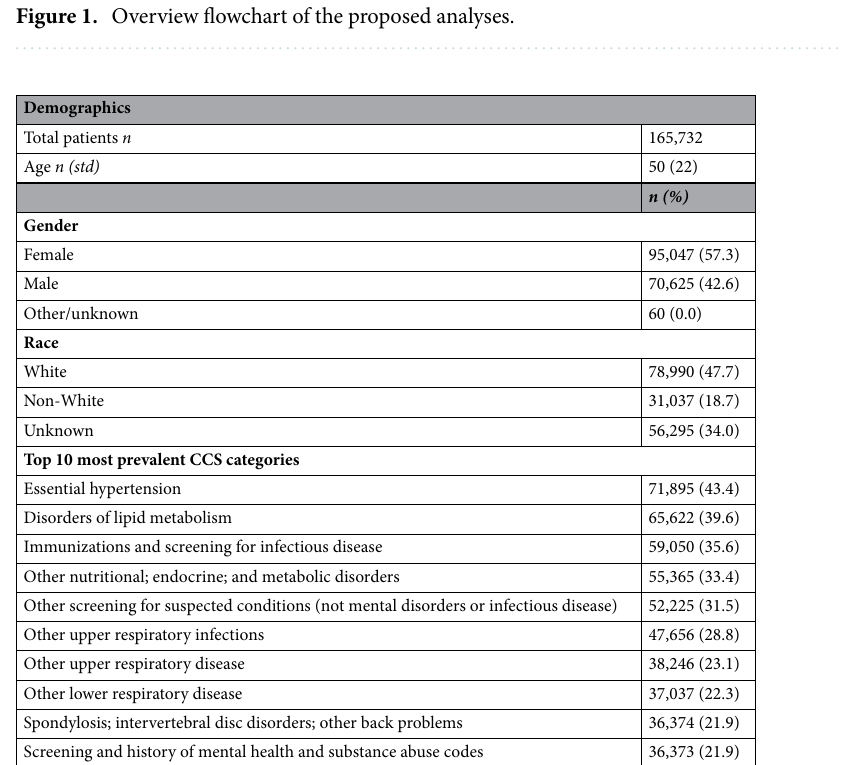
Figure 1. Overview flowchart of the proposed analyses.